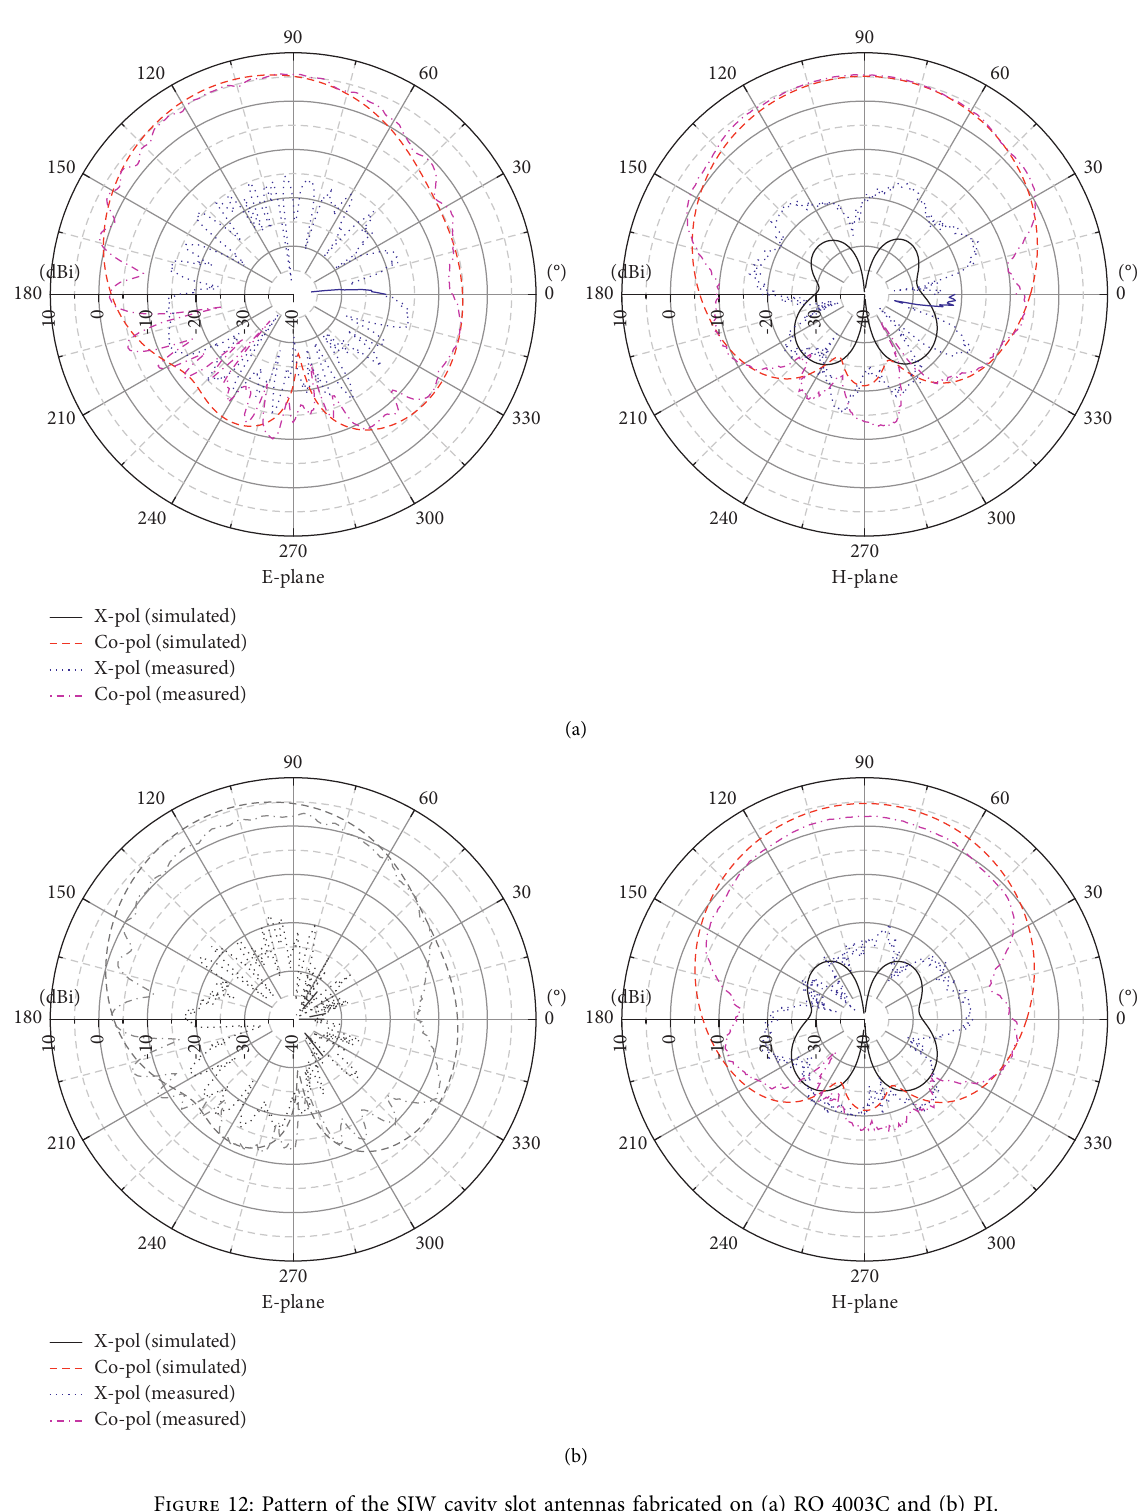
Figure 12: Pattern of the SIW cavity slot antennas fabricated on (a) RO 4003C and (b)